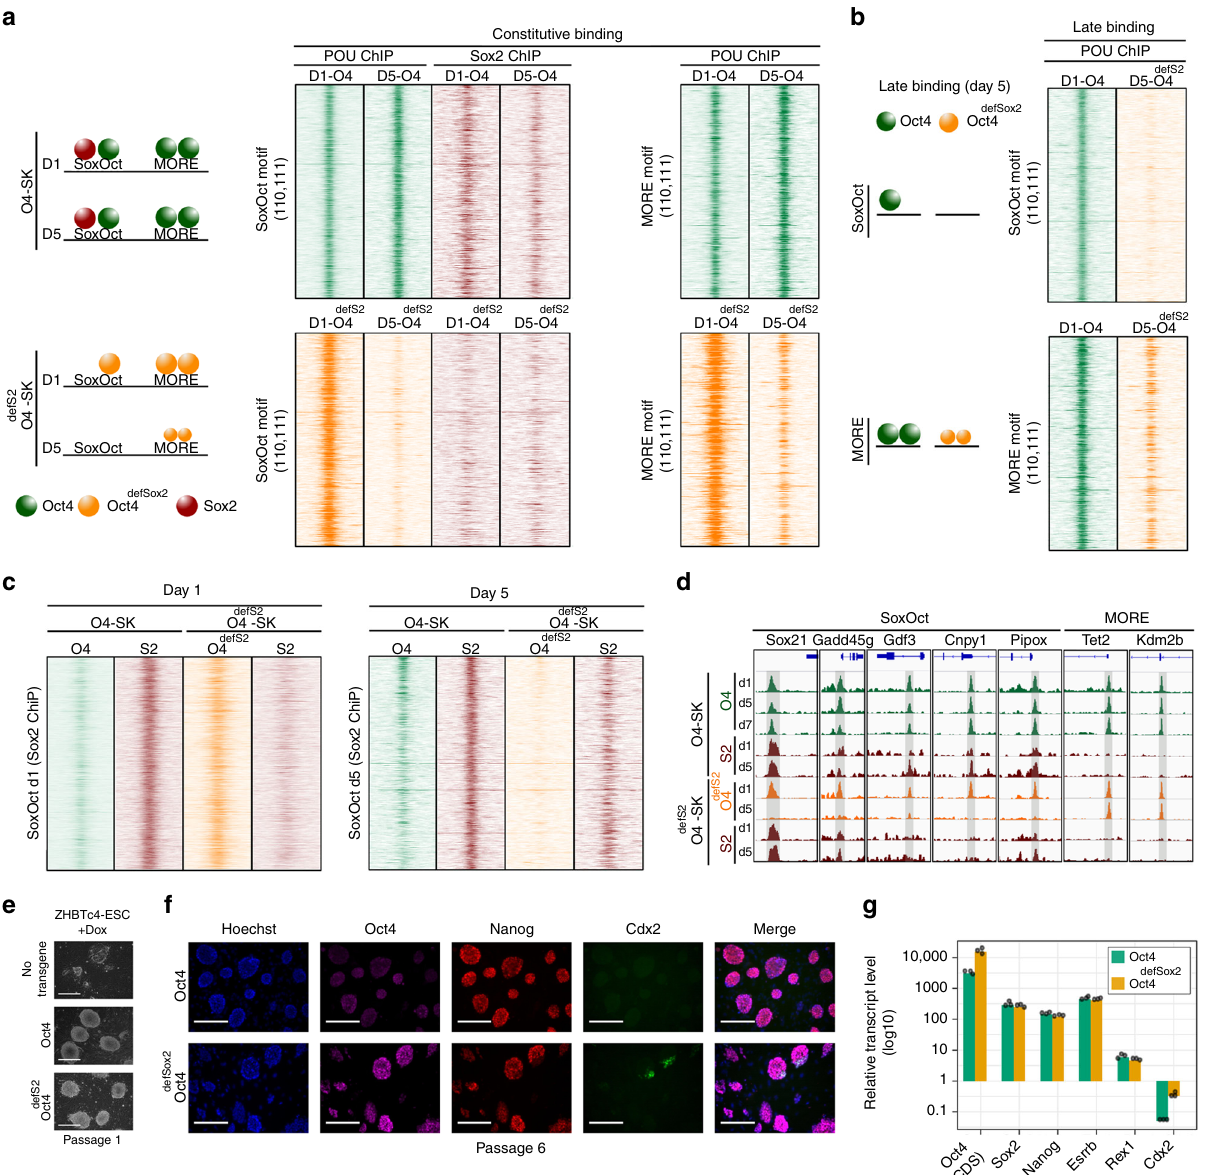
Fig. 5 Oct4 defSox2 targets pluripotency enhancers but eventually derails. a Heat maps of ChIP-seq reads at days 1 and 5 for Oct4, Oct4 defSox2 and Sox2 in Oct4-SK (top panels) or Oct4 defSox2 -SK (bottom panels) cocktails centered at Oct4 constitutively bound occupancy trajectories ( ‘ 110 ’ and ‘ 111 ’ ) containing SoxOct motifs (left panels) or MORE motifs (right panel). A cartoon on the left summarizes the results. b ChIP-seq reads at day 5 for Oct4 and Oct4 defSox2 for Oct4 late bound occupancy trajectories ‘ 010 ’ and ‘ 011 ’ at SoxOct (top) or MORE (bottom) locations. c Heatmap of Oct4, Oct4 defSox2 and Sox2 ChIP-seq signals at days 1 and 5. Rows are Sox2 ChIP-seq peaks called in the Oct4-SK condition containing SoxOct motifs at day 1 (left panel) and day 5 (right panel). ChIP-seq signal heatmaps in a , b and c are normalized using EAseq (DNA fragments per kilobase pairs (kbp) per million (M) reads) and shown for 2 kb genomic intervals centered on midpoints or motifs. d Genome browser tracks of selected Oct4, Oct4 defSox2 and corresponding Sox2 ChIP-seq peaks are shown at different days of reprogramming. The nearest genes and motif under the peaks are mentioned on the top. Genomic coordinates for the summits are listed in Supplementary Table 4. e Phase-contrast images of conditional Oct4 -knockout ZHBTc4 43 ESCs rescued with wild-type Oct4 or Oct4 defSox2 after culturing for 6 days in the presence of Dox (passage 1). Scale = 100 μ m. f Fluorescence images of ZHBTc4 ESCs rescued with wild-type Oct4 or Oct4 defSox2 after 6 passages in the presence of Dox. Scale = 100 μ m. The antibodies list is in Supplementary Table 11. g qRT-PCR analysis of selected gene expression of ZHBTc4 ESCs rescued with wild-type Oct4 or Oct4 defSox2 after 6 passages in the presence of Dox. The expression is relative to untransduced control induced with Dox for 7 days. Rpl37a was used as a house keeping gene. Individual data points are shown as black jitter plots ( n = 3, technical replicates). The primers for Oct4 CDS (coding DNA sequence) and other markers are mentioned in Supplementary Table 10 and Source data are provided as a Source Data fi